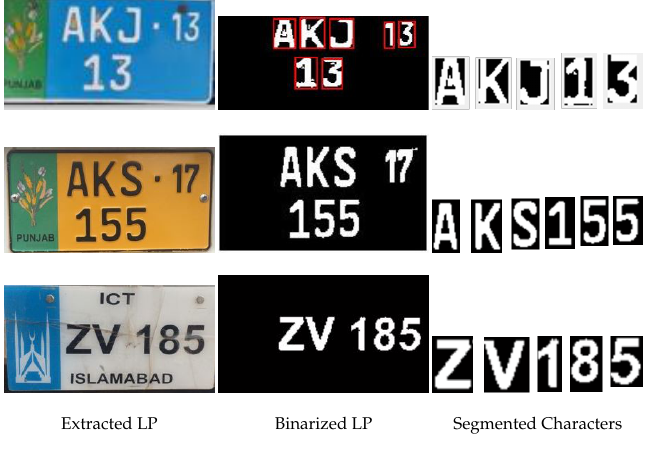
Figure 11. LP extraction, binarization and character